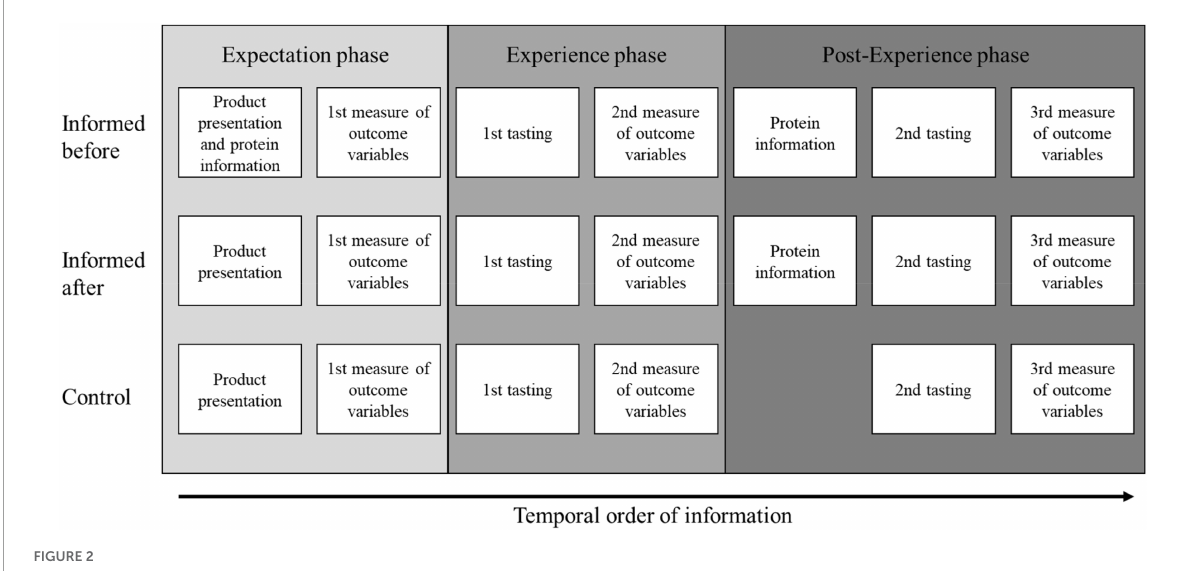
FIGURE2 Research design.